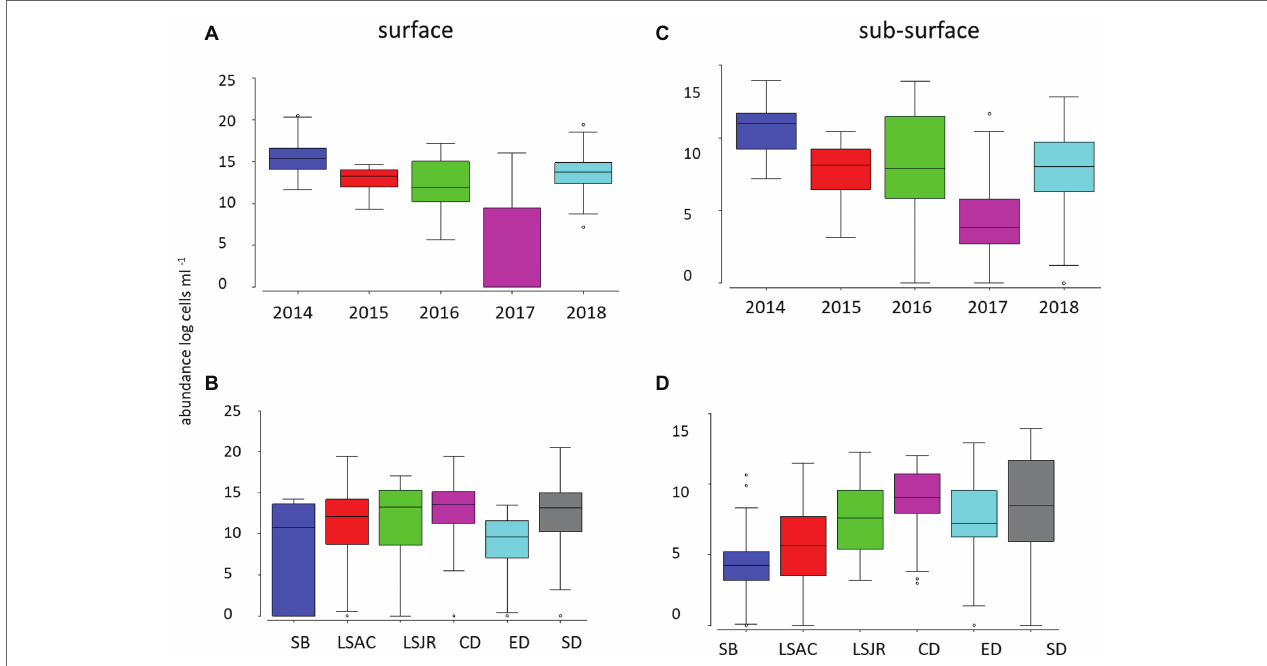
FIGURE 2 | Average (line), 25th and 75th percentiles (box), and maximum and minimum (whiskers) concentration of Microcystis abundance for 2014 through 2018 at 10 stations in the USFE in surface net tows measured by microscopy among years (A) and among regions (B) and in the subsurface water by quantitative PCR (qPCR) among years (C) and regions (D) . Stations were grouped into the following six regions based on station location: Suisun Bay (SB, station D8), lower Sacramento River (LSAC, stations D4 and D22), lower San Joaquin River (LSJR, stations D12 and D16), central Delta (CD, stations D19 and D28A), east Delta (ED station MD10A), and the south Delta (SD, stations D26 and